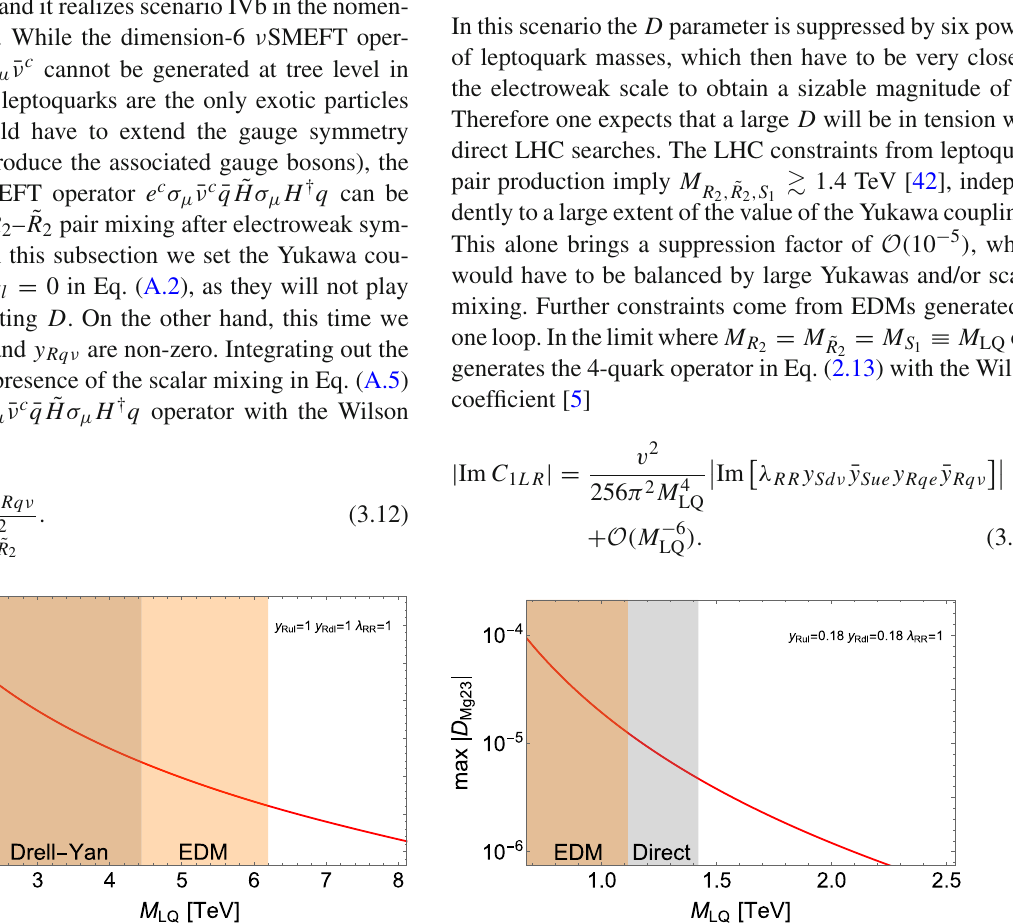
Fig. 1 Maximum value of the D parameter in 23 Mg (red line) possi- ble in the model with two leptoquarks R 2 and ˜ R 2 for two particular choices of the leptoquark Yukawa couplings and for the scalar mixing parameter λ RR = 1. Left: For y Rul = y Rdl = 1 the colored parameter space is excluded by pp → e + e − (Drell–Yan) [43] and by the neutron EDM. The latter dominate and force the leptoquark mass scale to be